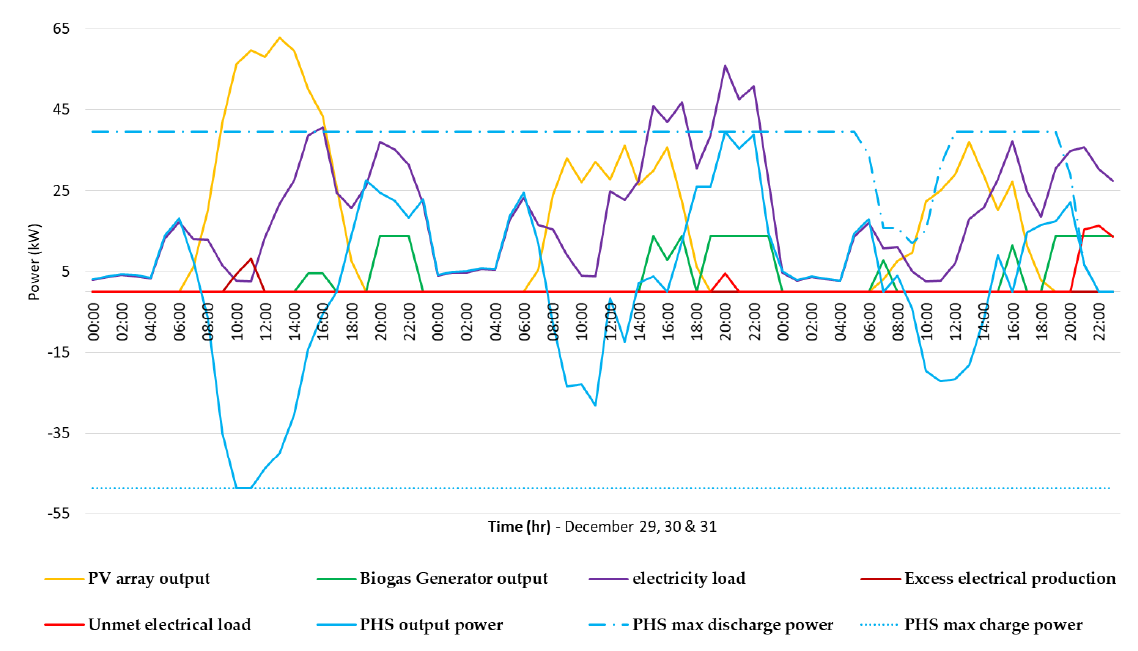
Figure 16. Operations schedules and energy flow of the system components over a 72-hour period.